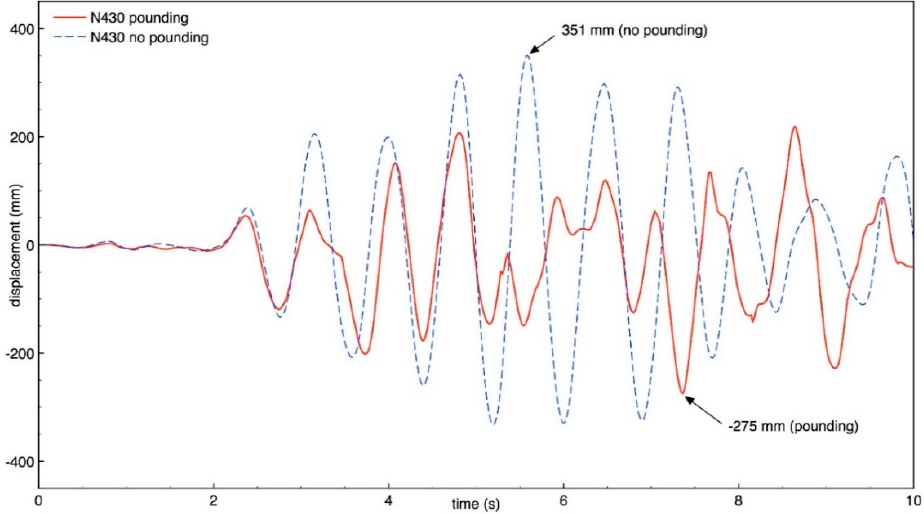
Figure 17. Longitudinal response of building B (node N430) with and without pounding.